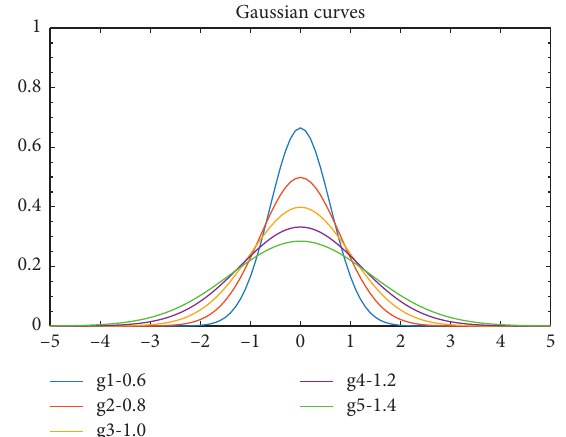
Figure 1: The distributions of five Gaussian